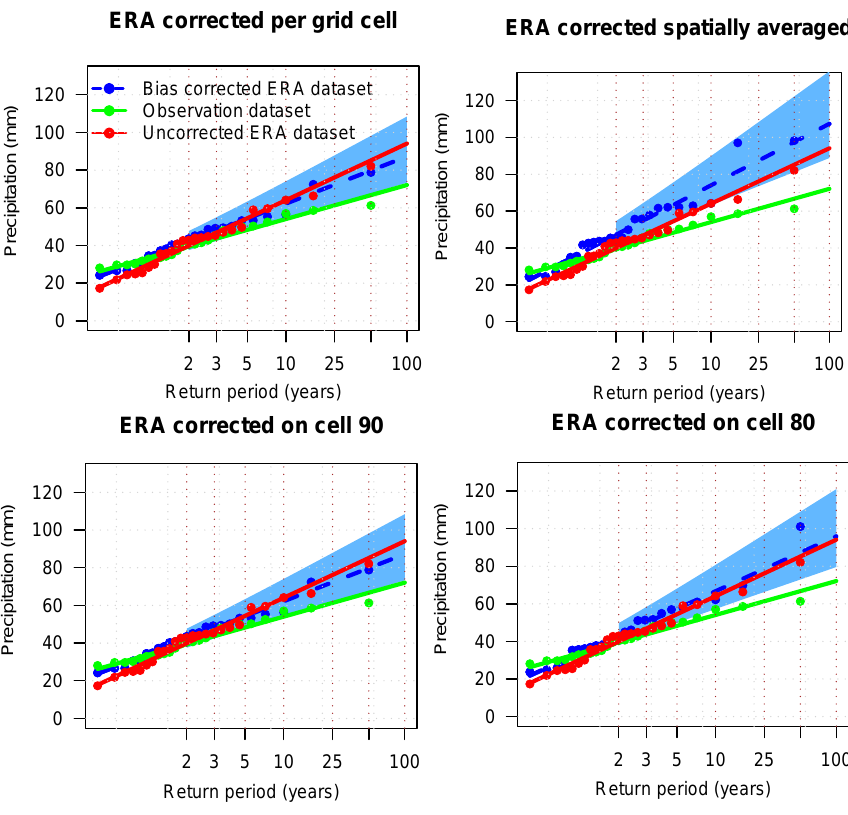
Fig. 5. Gumbel plots of annual maxima of daily precipitation sums of cell 90 for the period 1979–2003. The shaded area is the 95% confidence interval of the bias-corrected dataset. The four panels show results for the four employed bias correction methods. cell 90 has the highest mean value as well as the highest stan- dard deviation. To investigate extreme values as well, Fig. 5 shows the sorted annual maximum daily precipitation sums of cell 90 versus their return period over 25 years and fits a Gumbel distribution through the data points. Each subplot consists of three datasets of which the observations, the green line, and the uncorrected dataset, the red line, are shown in every plot to put the bias-corrected dataset, that is plotted in blue, in